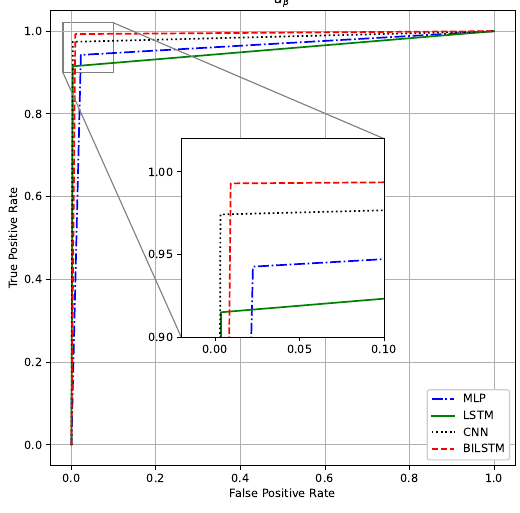
Figure 15. ROC curve for u β .